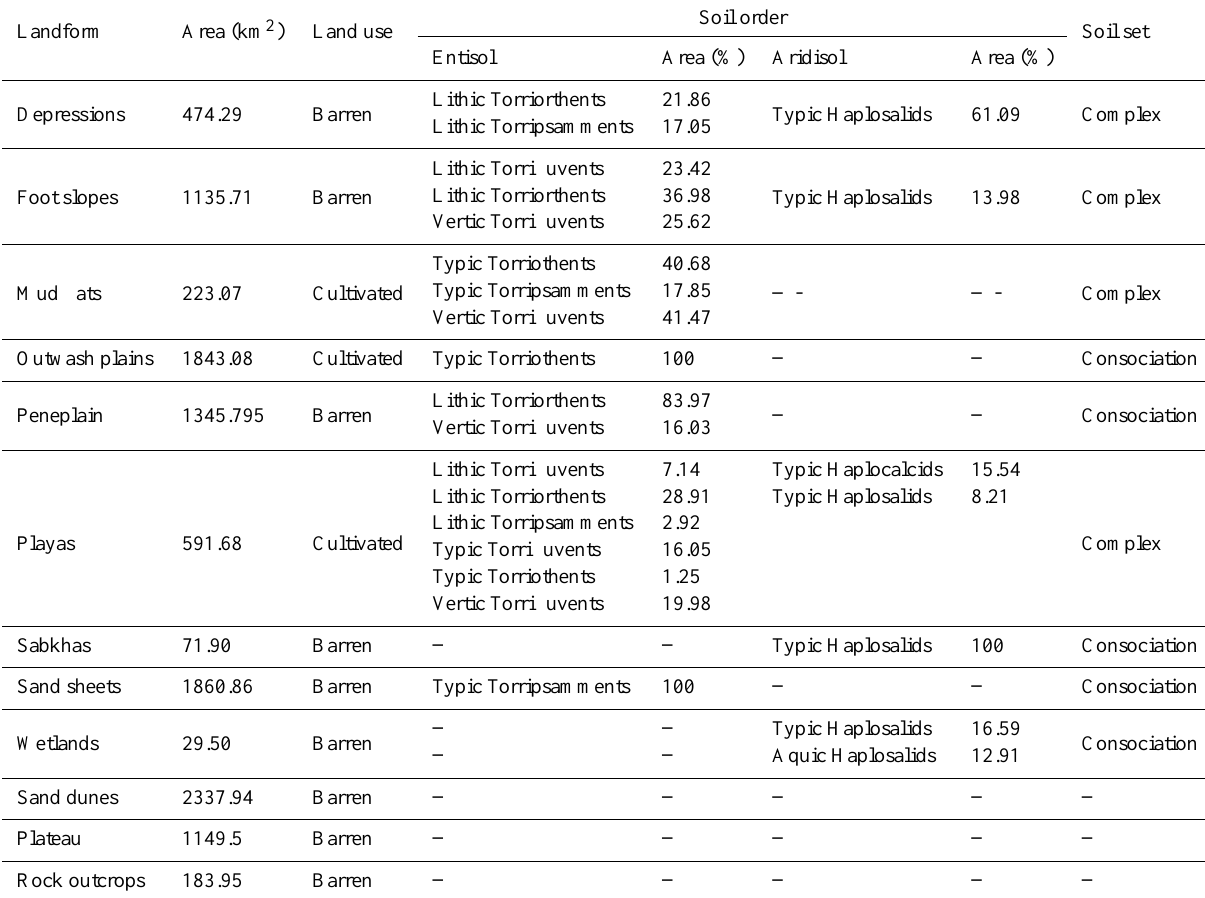
Table 1. The main landforms and their associated soil classes in the Farafra depression.